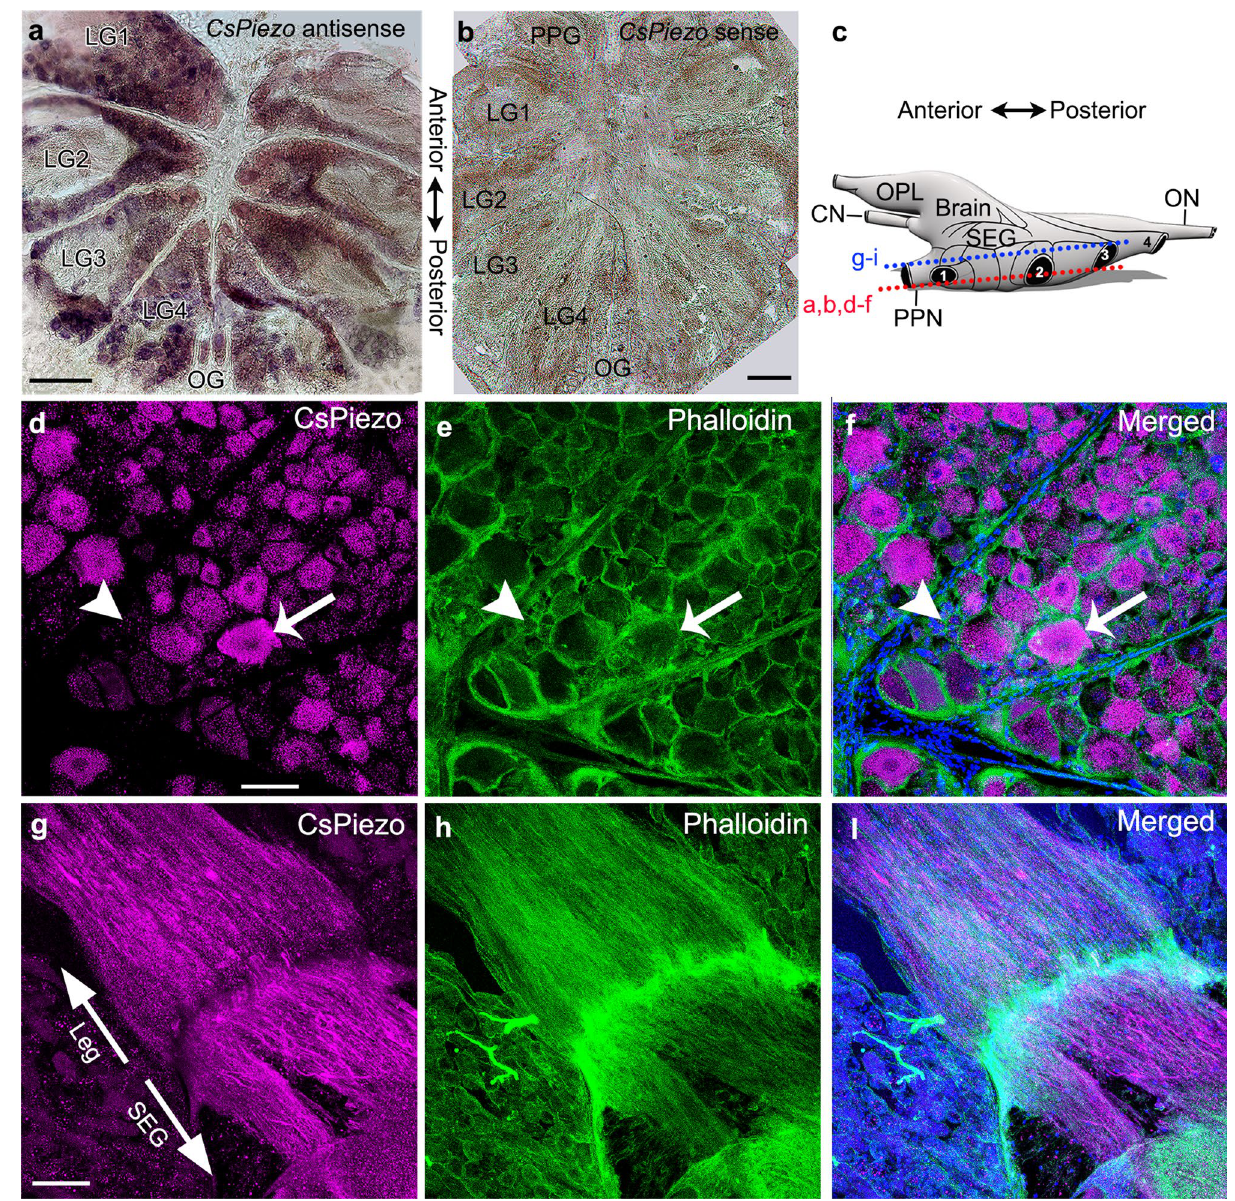
Figure 5. CsPiezo expression in the C. salei subesophageal ganglia (SEG). ( a ) An antisense probe for CsPiezo produced a strong signal in the cell bodies of many neurons located in the ventral region of the SEG. b . The sense ( control ) probe did not produce any signal. ( c ) Schematic drawing depicting a lateral view of the spider brain mass 45 . Approximate locations of the cross sections are indicated with red (a, b, d-f) and blue (g-i) dashed lines. ( d–f ) CsPiezo antibody ( d , magenta ) labeling in the somata of many neurons in the leg ganglia in the ventral SEG. Arrow points to one strongly labeled large soma. Phalloidin staining ( e , green ) in the actin filaments reveals many neurons that were not labeled with CsPiezo ( arrowhead ), or the labeling was weak. ( g–i ) The leg nerves are found in the dorsal region of SEG which is devoid of neuronal cell bodies. The leg nerves were strongly labeled by CsPiezo ( g ) and Phalloidin ( h ). Blue DAPI staining in merged images f and i in cells surrounding the leg nerves. Scale bars in a and b are 200 µm, in d–i 100 µm. LG = leg ganglia, OG = opisthosomal ganglia, ON = opisthosomal nerve, PPG = pedipalpal ganglia, OPL = optic lobes, CN = cheliceral nerve, PPN = pedipalpal DEG/ENaC channels, it also inhibits other ion channels and transporters 4,56,58 . Moreover, the effective amiloride concentration in C. salei VS-3 neuron experiments was 1 mM 33 which is significantly higher than is needed to block mammalian ENaC and ASIC channels 4 or C. elegans MEC4 channels 48 . Different combinations of the TRP subunits NompC, Nan and Iav contribute to mechanotransduction in several insect sensory organs 5,7,9,11–13 . We found orthologs to all these channels in the spider transcriptome, but in situ hybridization suggests that they are not expressed in the patellar mechanosensory cells and are unlikely